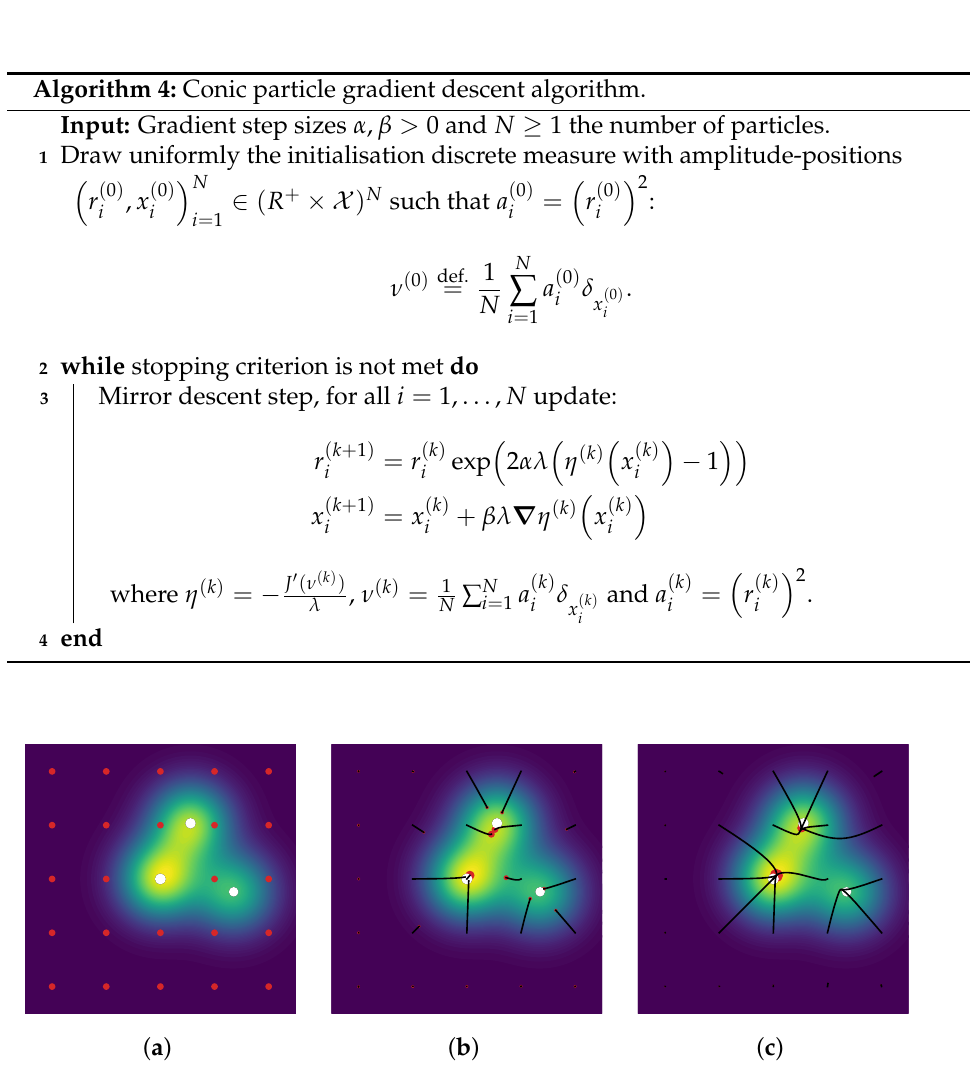
Figure 8. ( a ) Initialisation k = 0; ( b ) mid-computation k = 150; ( c ) end of the computation k = 1000. Conic Particle Gradient Descent applied for 2D Gaussian deconvolution, the red dots are the particle measure ν ( k ) (size of dot proportional with amplitude), the three white dots are the source measure, the image in the background is the noiseless acquisition y 0 and the black lines are the paths of the particles ν ( k ) —all the paths constitute the gradient flow ( ν t ) t ≥ 0 . Implementation is an adaptation of [23], α = β = 1 × 10 − 2 and λ =